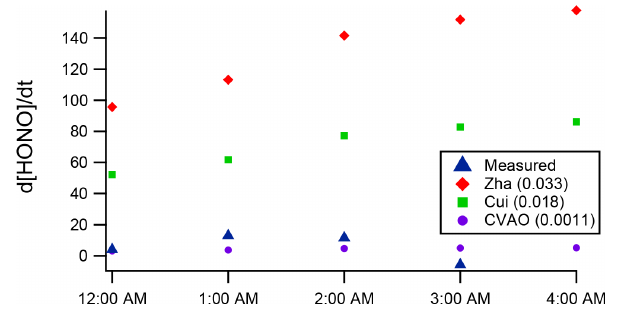
Figure 7. Measured (blue) night-time HONO production, d [ HONO ] / d t (ppth − 1 ), during the 3 July case study night at WAO, compared to calculations via Eq. (1) for a range of C HONO